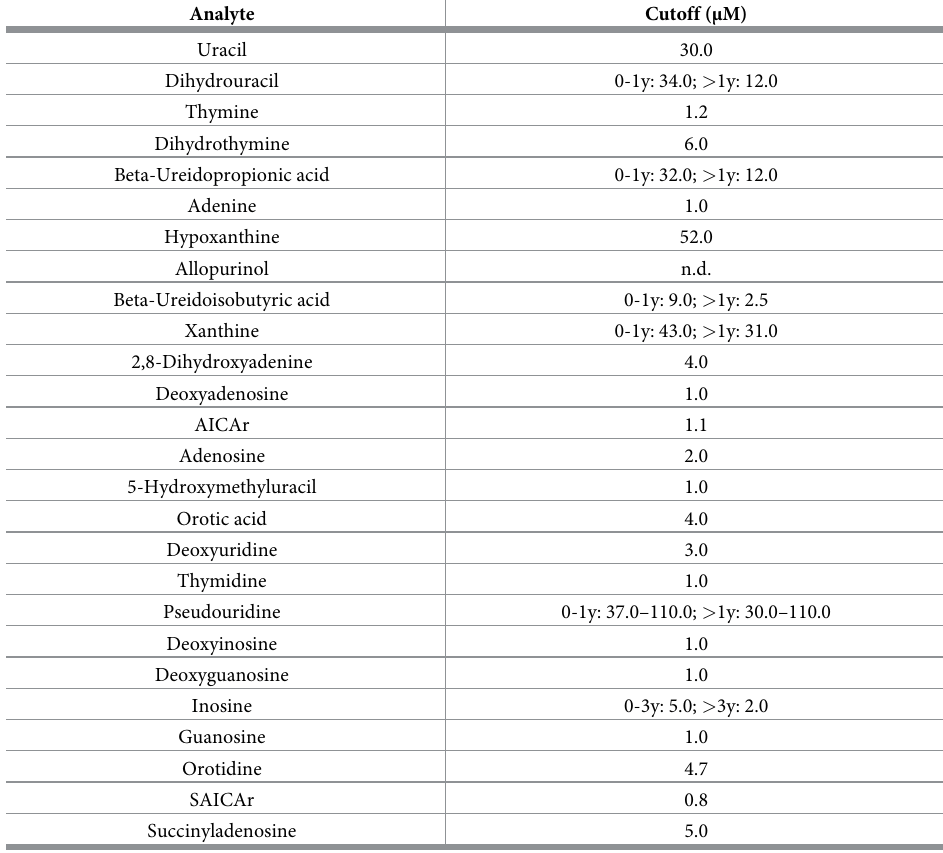
Table 4. Cutoff values of the measured analytes.